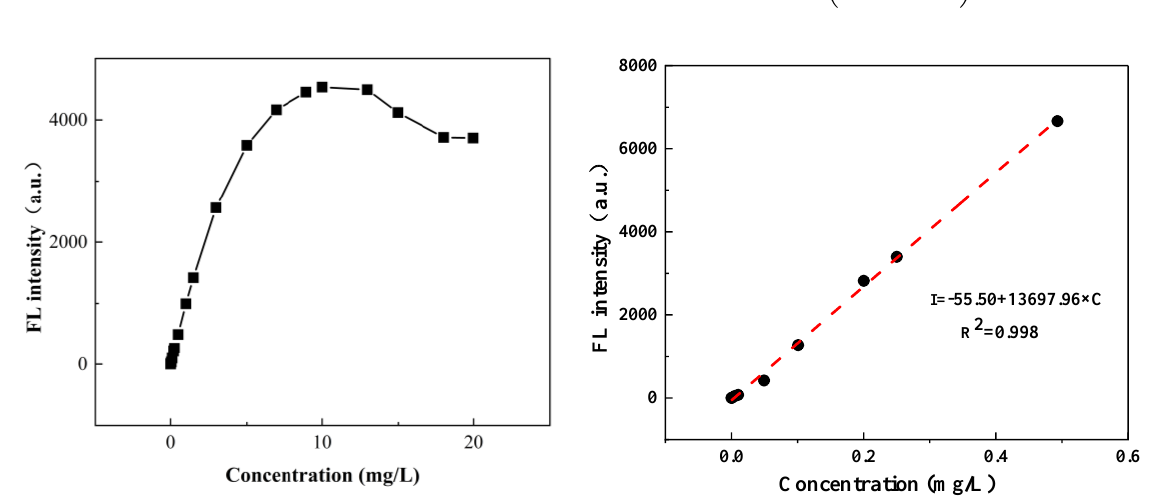
Figure 7. The concentration of CQD-W versus fluorescence intensity (bandwidth 10, gain 7).